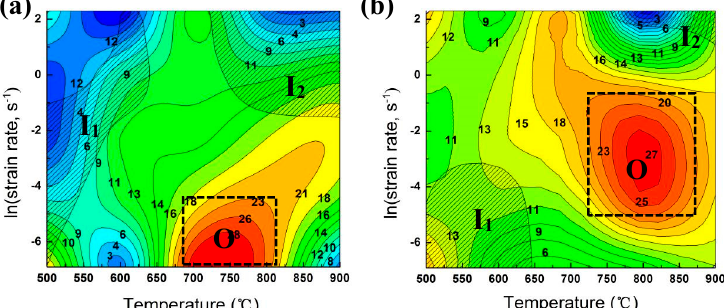
Figure 10. Hot processing maps of: ( a ) Cu-Ni-Co-Si-Cr and ( b ) Cu-Ni-Co-Si-Cr-Ce alloy. The shaded areas represent instability domain. The boxes represent the optimal processing domain. O : Optimal Processing Domain. I : Instability Domain.